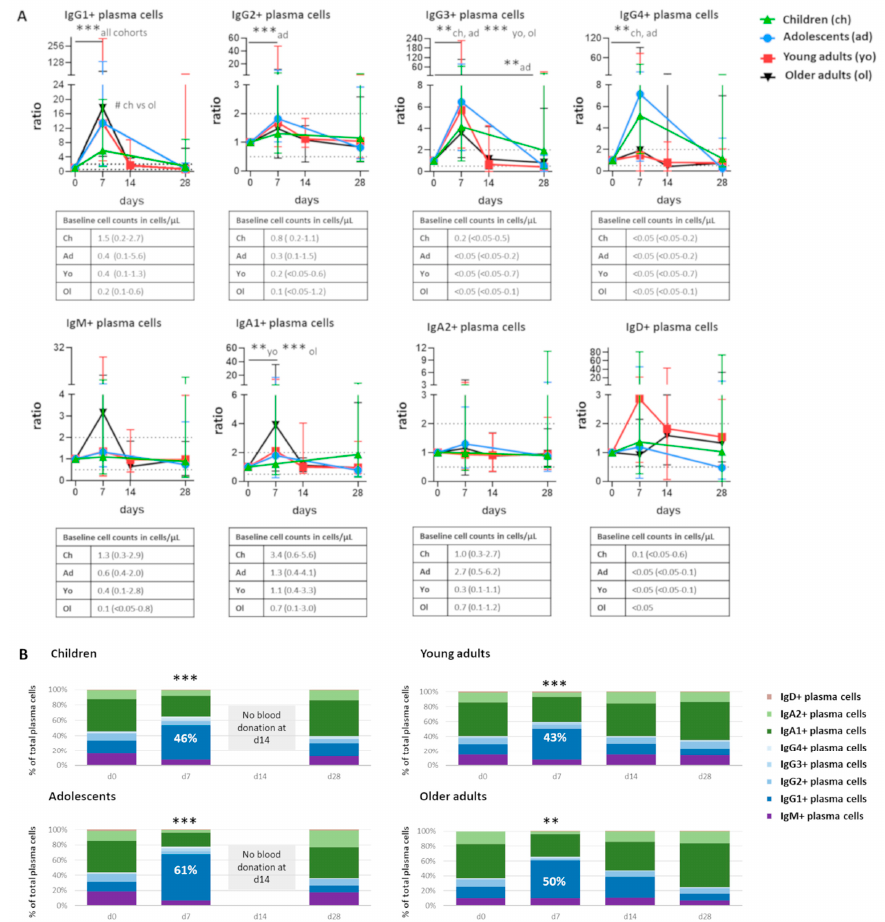
Figure 2. Individuals of all age groups underwent expansion of IgG1+ plasma cells at day 7 postvaccination. ( A ) Quantitative changes in plasma cells expressing different Ig subclasses, presented as ratio over baseline (median, min-max). Each symbol represents a median value with range. Dashed lines indicate a ratio over baseline of 0.5 and 2. Underneath each graph, the baseline cell counts per cohort are presented in cells/ µ L (median, min-max). Wilcoxon matched pair signed-rank test followed by Bonferroni correction was used to assess longitudinal differences within each cohort. Differences in ratio at day 7 between cohorts were assessed using Kruskal–Wallis followed by Dunn’s test. ( B ) Over-time distribution of plasma cells expressing different Ig subclasses. Median values for each population were used to construct the plots. Wilcoxon matched pair signed-rank test followed by Bonferroni correction was used to assess longitudinal differences in the percentage of IgG1+ cells in the total plasma cell compartment within each cohort. Differences in the percentage of IgG1+ cells in total plasma cell compartment between cohorts were assessed using Kruskal–Wallis followed by Dunn’s test but did not yield significant differences. For pediatric cohorts, no blood samples were collected at day 14; the Mann–Whitney test followed by Bonferroni correction was used. For longitudinal changes, only significant differences compared with baseline are shown. Significant lon- gitudinal differences within a cohort are indicated as **, p ≤ 0.01; ***, p ≤ 0.001. Significant differences between cohorts at the same time point are indicated as #, p < 0.05. d = days after